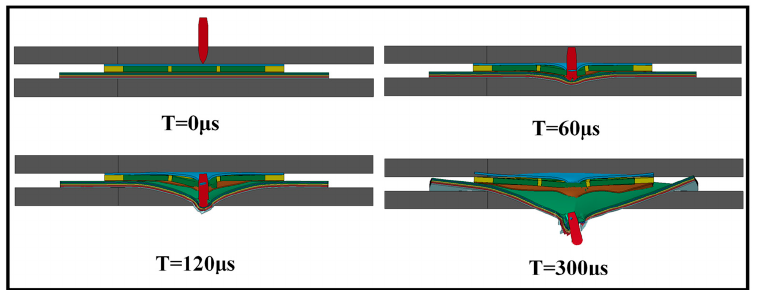
Figure 6. Simulation of the penetration of T-V by the projectile at 673 m/s. Table 7. Comparison of ballistic test results with numerical simulation results.